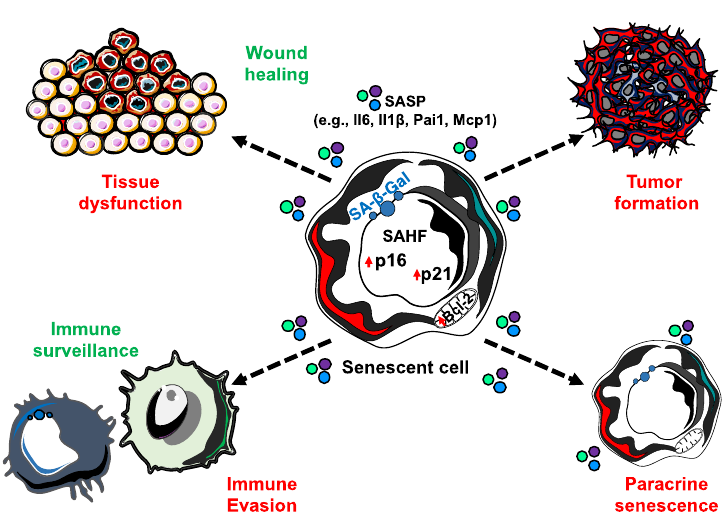
Figure 2. The senescence-associated secretory phenotype (SASP) is able to elicit a number of biological effects. While senescent cells are incapable of proliferation, they remain metabolically active and capable of secreting an array of bioactive molecules that have extrinsic impacts. SASP factors can function both in beneficial (green) and detrimental (red) biological processes.